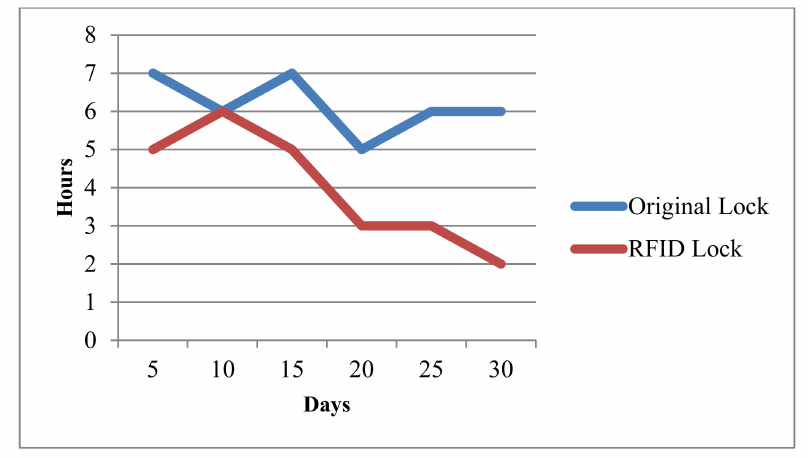
Figure 8. The average maintenance time compared between the RFID lock and the original